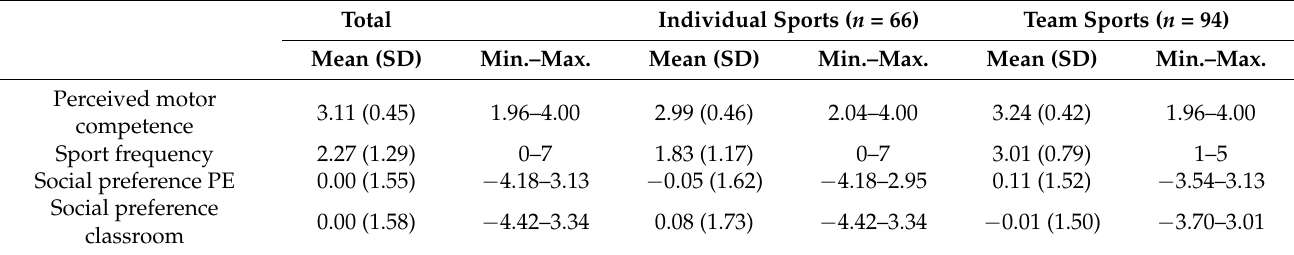
Table 1. Mean scores on sports frequency, type of sports, perceived motor competence and social acceptance in PE and the regular